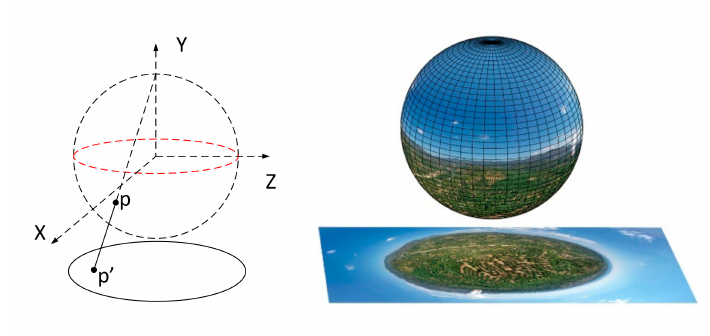
Figure 4. Stereographic projection of 360-degree